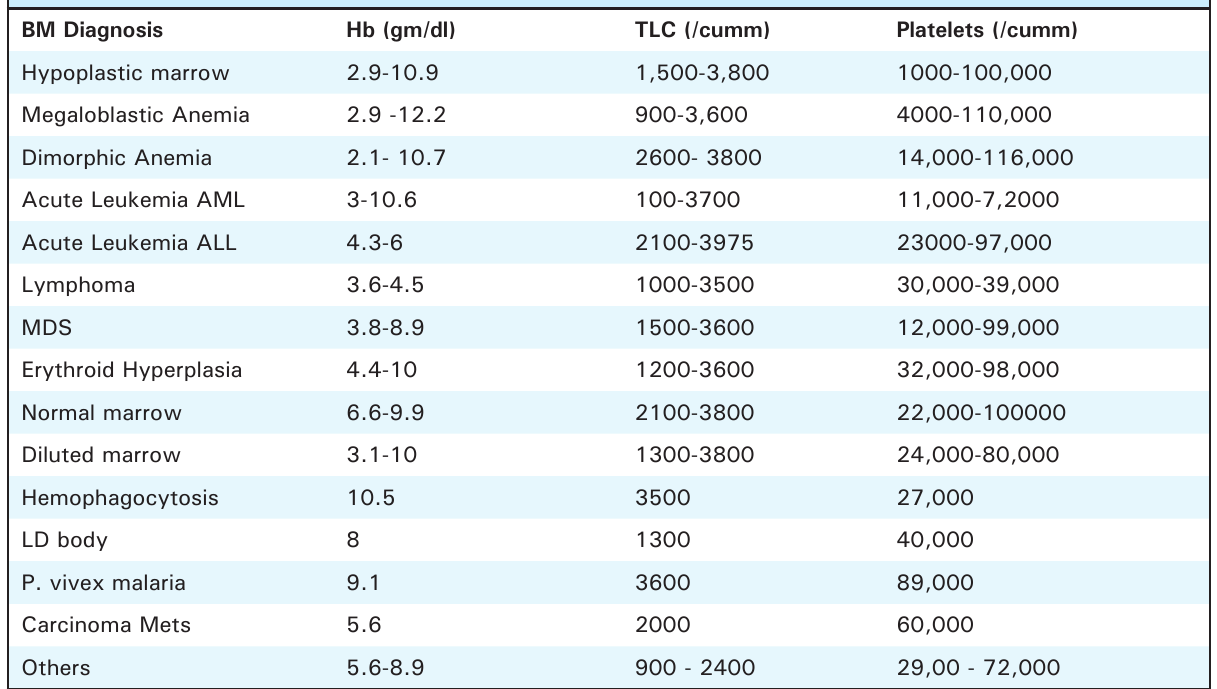
Table 3. Hematological parameters of pancytopenia